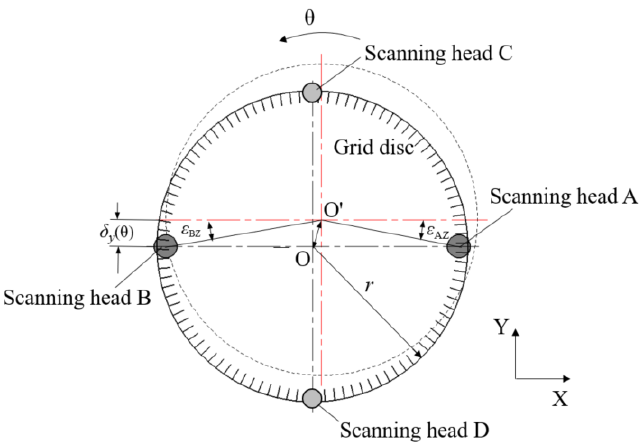
Figure 2. Measurement of rotation angle when error existing.